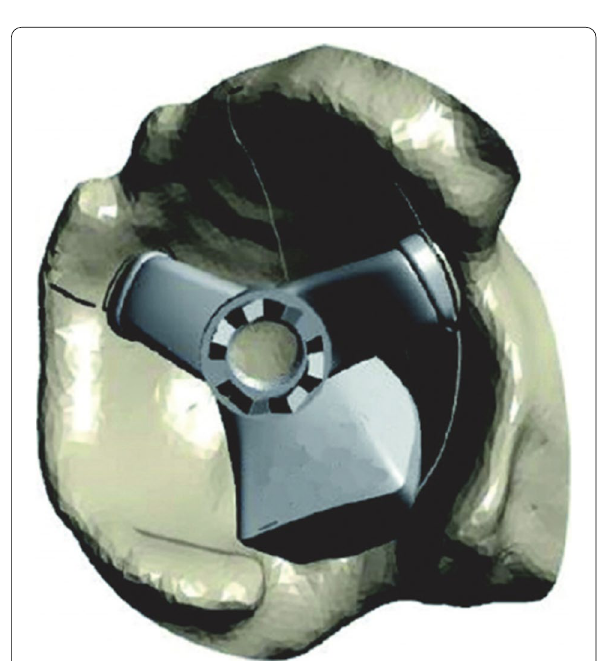
Fig. 2 Acetabular orientation guide in provided 3D